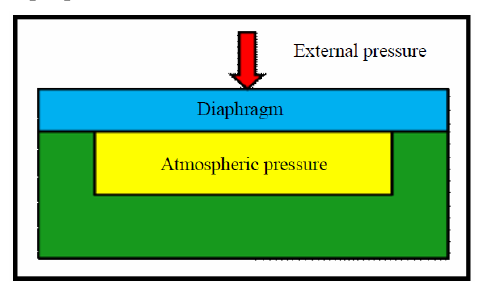
Fig. 5 Schematic representation of sealed gauge or relative pressure sensor.